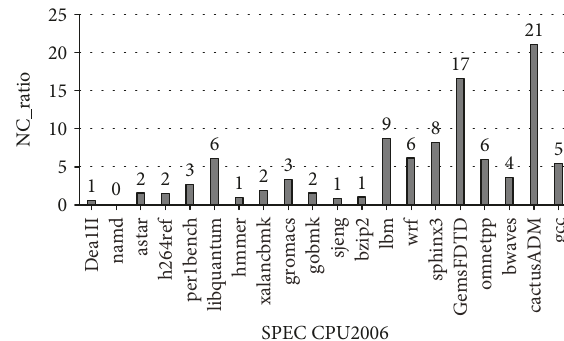
Figure 8: Average NC_ratio of SPEC CPU2006.